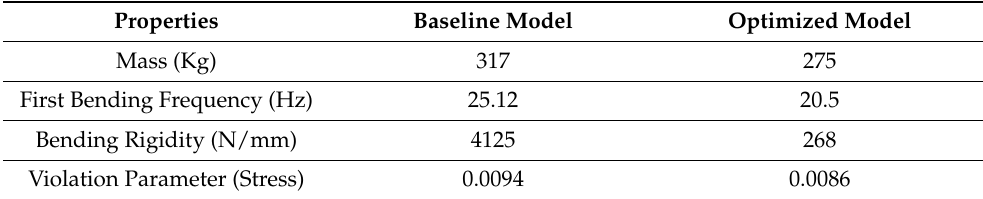
Figure 18. Von Mises stress distribution of optimized design for ( a ) Event #1, ( b ) Event #2, ( c ) Event #3, ( d ) Event #4 and ( e ) Event #5. Table 5. Comparison between baseline and optimized